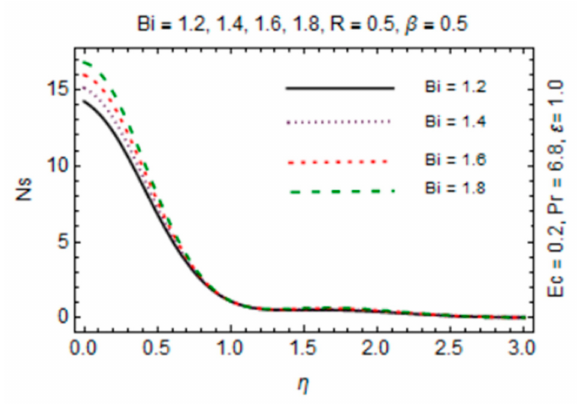
Figure 17. Bi verses entropy generation